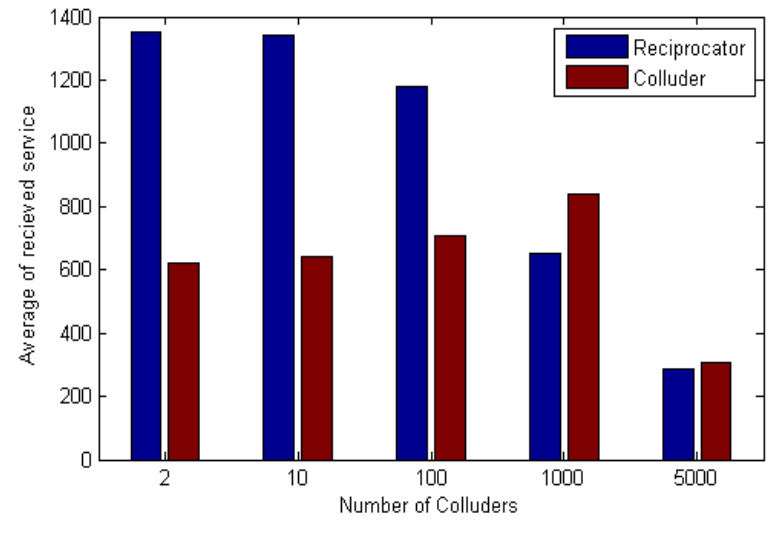
Figure 8. Average of received service in round 200.